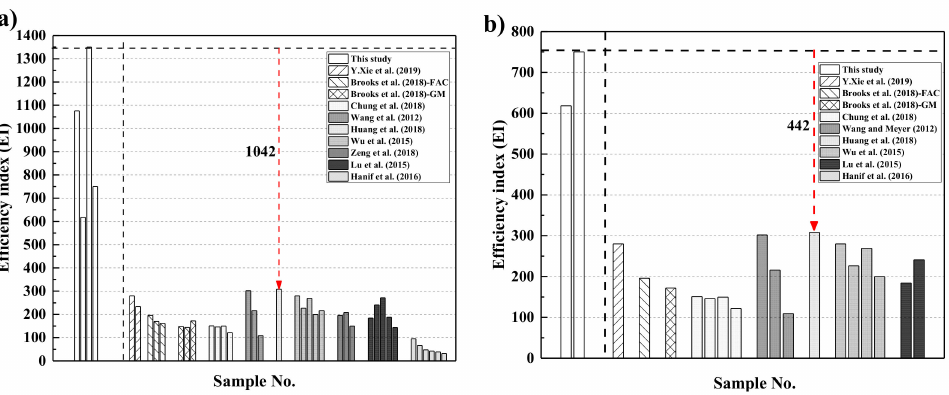
Figure 14. E ffi ciency indices for contemporary works with: ( a ) thermal conductivities less than 1.0 W / m · K and ( b ) thermal conductivities less than 1.0 W / m · K as well as satisfying minimum strength criteria (i.e., 40 MPa).